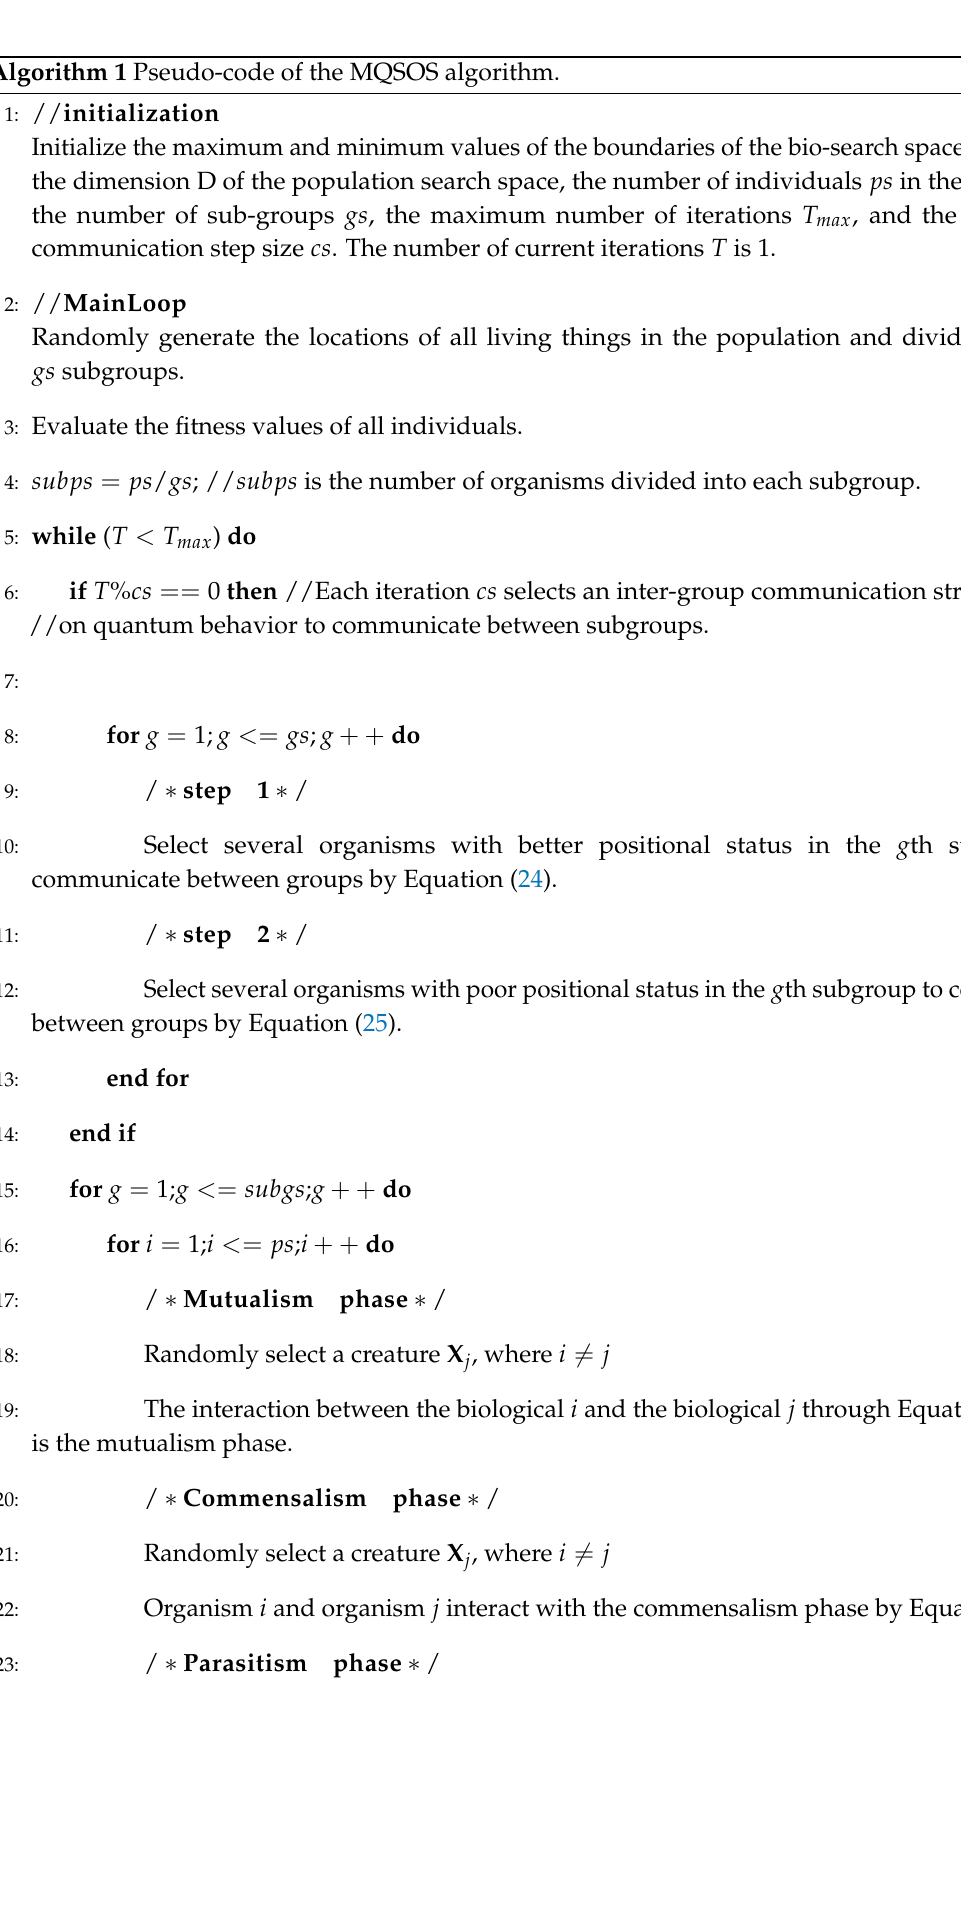
Algorithm 1 Pseudo-code of the MQSOS